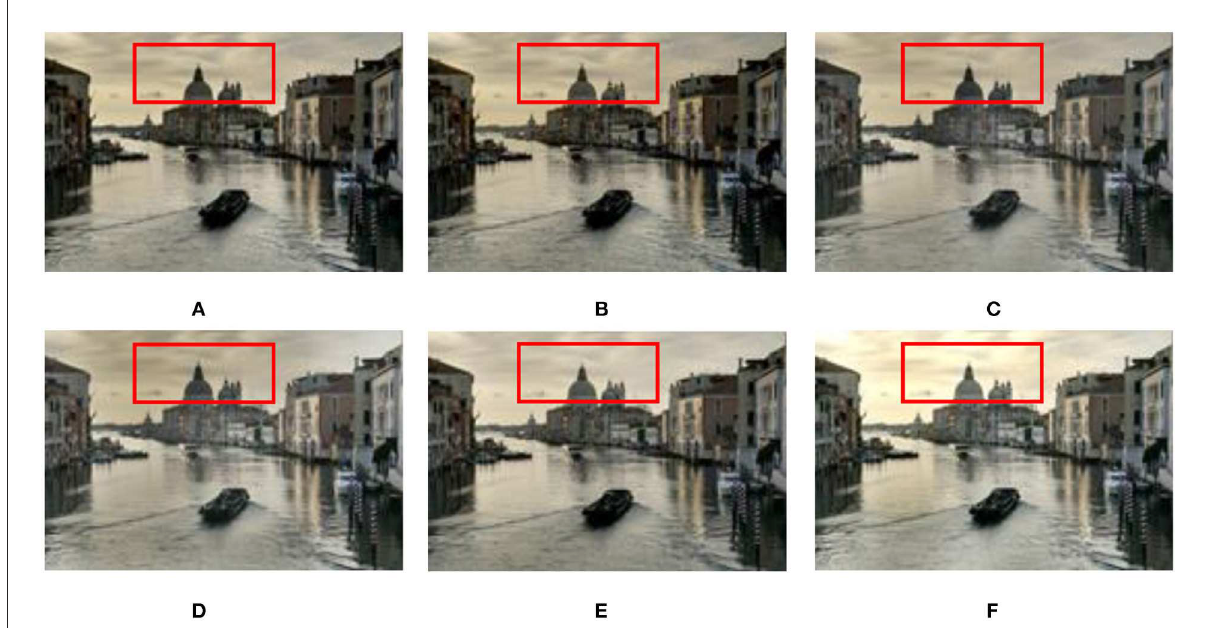
FIGURE10 Comparison of the proposed method with Mertens et al. (2007), Li and Kang (2012), Hayat and Imran (2019), Liu and Wang (2015), and Lee et al. (2018) in the static “Venice” image sequence. (A) Hayat and Imran (2019); (B) Mertens et al. (2007); (C) Li and Kang (2012); (D) Liu and Wang (2015); (E) Lee et al. (2018); (F) the proposed method in this